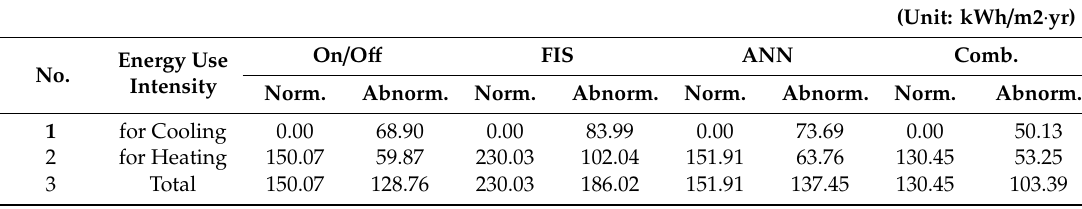
Table 3. Comparison of energy e ffi